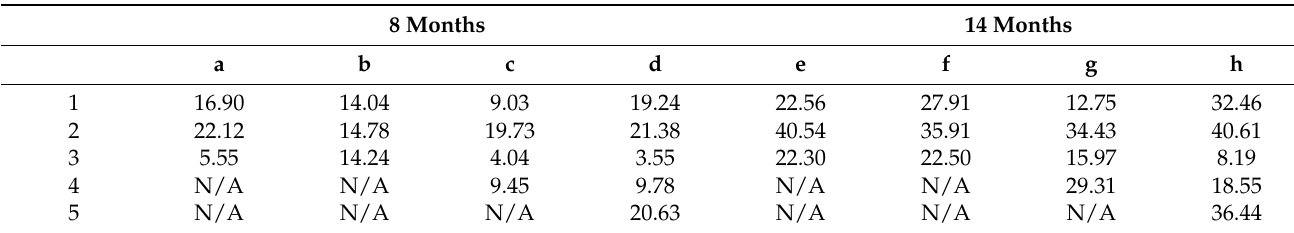
Figure 7. ( A ) CAA in the brains of 8-month-old ( a – d ) and the same location in 14-month-old ( e – h ) AD mouse models. Scale bar: 100 µ m. ( B ) The percentage (%) of A β deposition in 15 locatable per unit length vessels in 8-month-old and 14-month-old mice. ( C ) Average percentage (%) of A β deposition. Data represent mean ± SD from independent replicates. Asterisks denote significance compared with 8 months group and 14 months group (** p < 0.01, t -test). Table 2. A β deposition rate (%) per unit vessel length in 8-month-old and 14-month-old